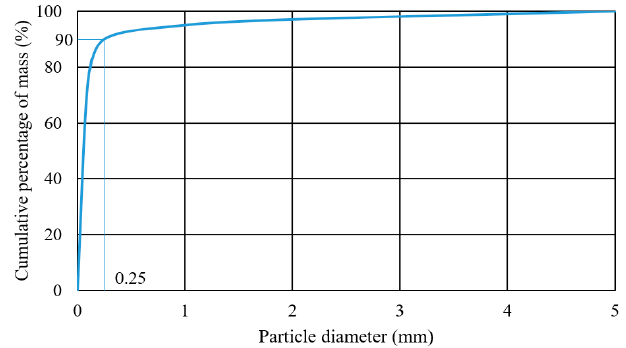
Figure 12. Particle size distribution of the soil used in the testbed.